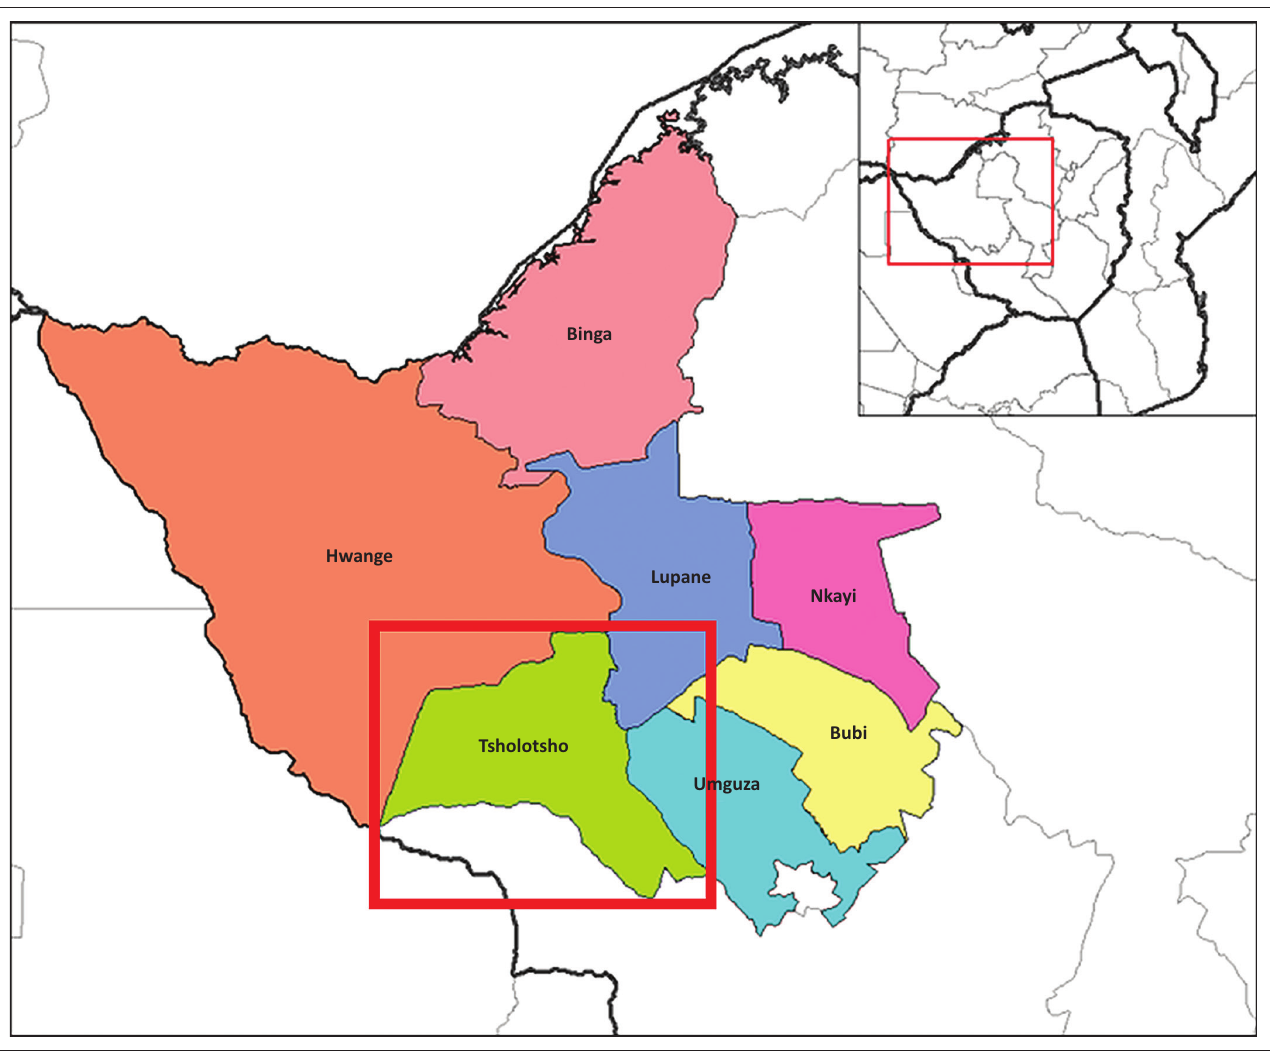
FIGURE 1: The position of Tsholotsho district on the Map of